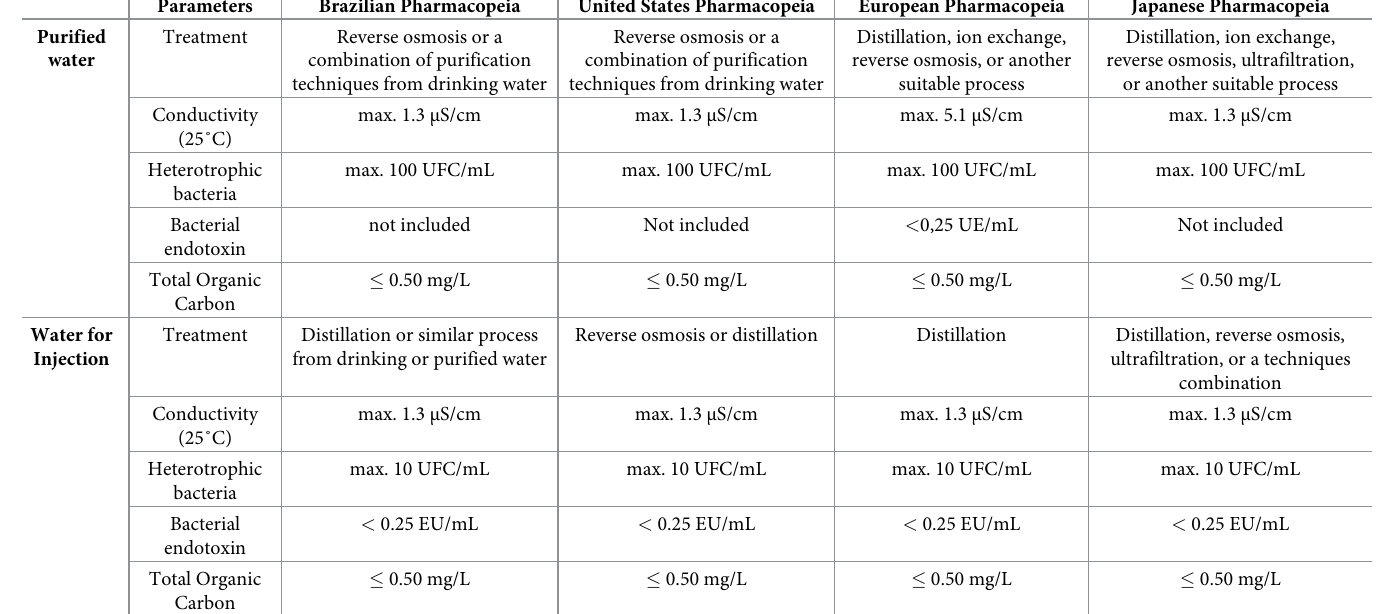
Table 1. Treatment steps and parameters of purified water and purified water for injection or water for injection considering pharmaceutical compendiums [23–